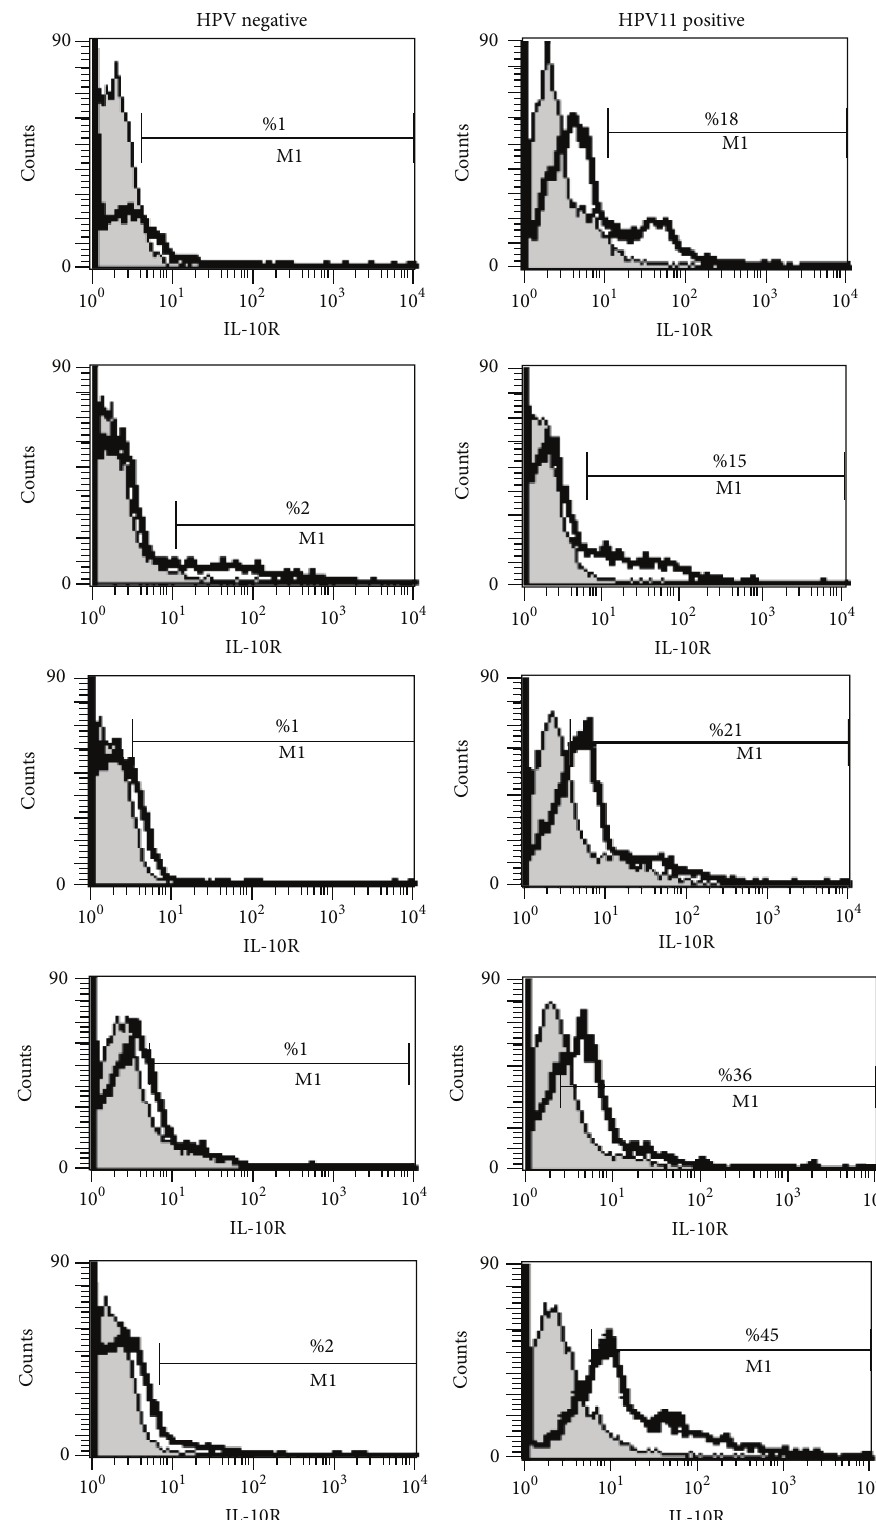
Figure 4: IL-10R expression on epithelial cells from HPV negative and HPV-11 positive SNP-WoAD patients. Grey histogram: anti-isotype controls (Exbio) and white histogram: IL-10R (anti-IL-10RPE)